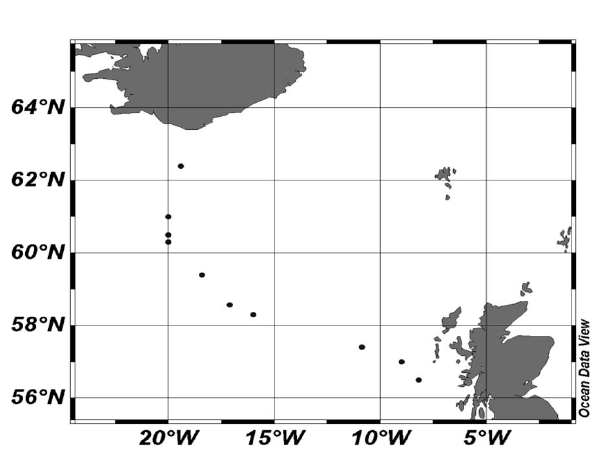
Fig. 1. Stations sampled during the D340a Extended Ellett Line Cruise to the North Atlantic in June 2009 (black